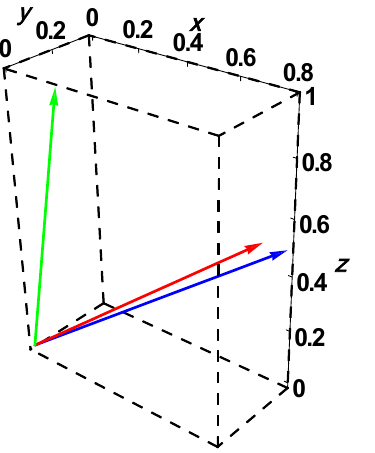
Fig. 6 Axes of rotation in real space: for quarks – green arrow, for neutrinos Best Fit 2018 – blue arrow, for neutrinos in CBM parameter- ization with 3 σ spread of Best Fit 2018 – red arrow